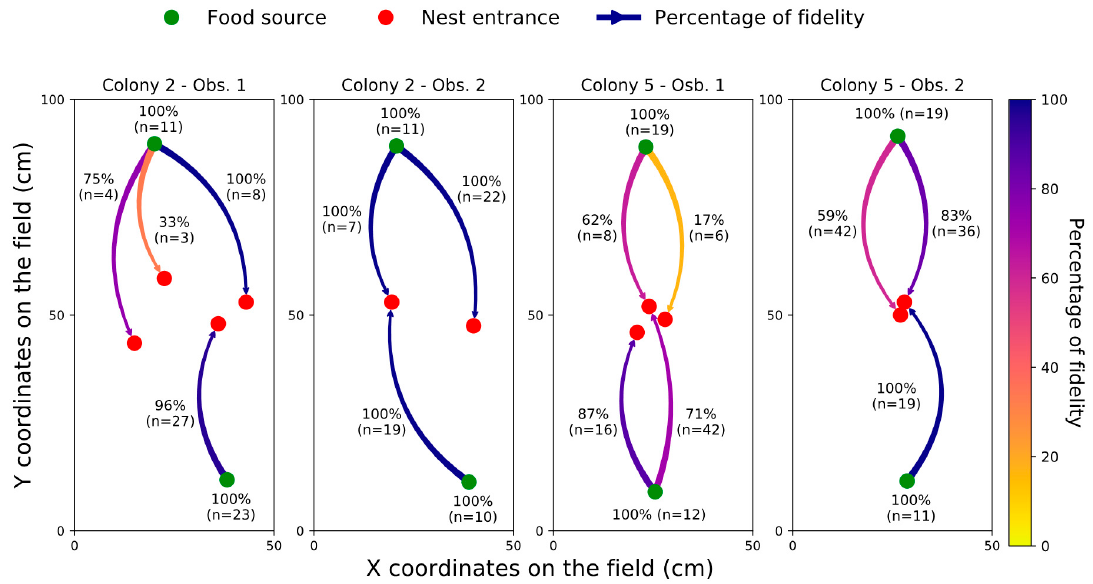
Figure 3. Fidelity of foragers to the entrance they first exited and to the food source they first exploited . The label of the arrows indicates the proportion of ants returning to their entrance (red dots) of initial departure and, in brackets, the total number of tracked journeys (n). The label of the food sources (green dots) indicates the proportion of foragers returning at the feeder that they had first visited and, in parenthesis, the total number of marked ants observed at this feeder (n).